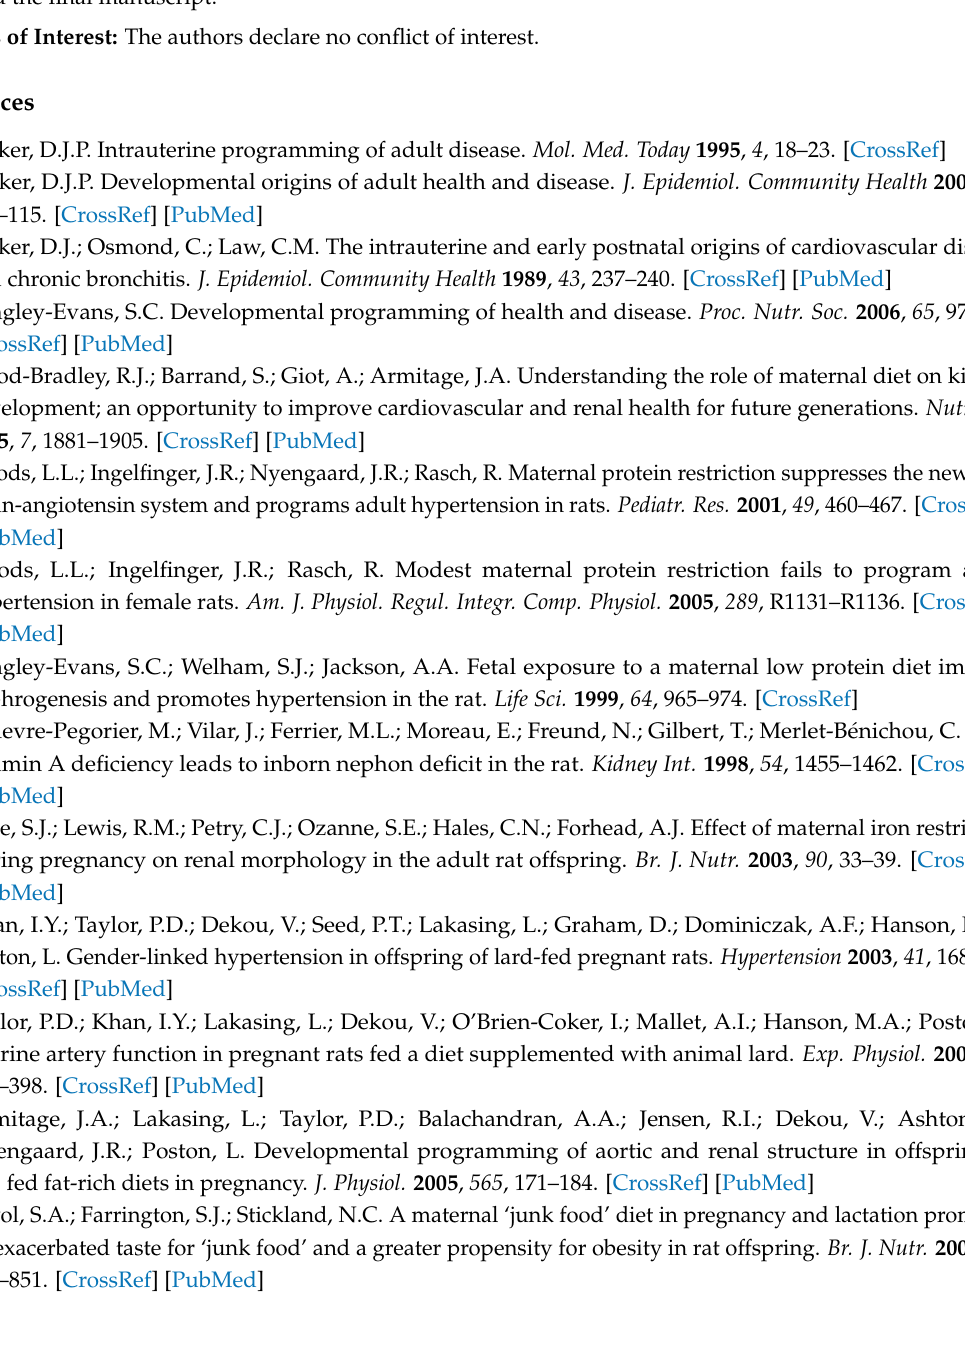
Table S1: Results of study quality based on the American Dietetic Association (ADA) Quality